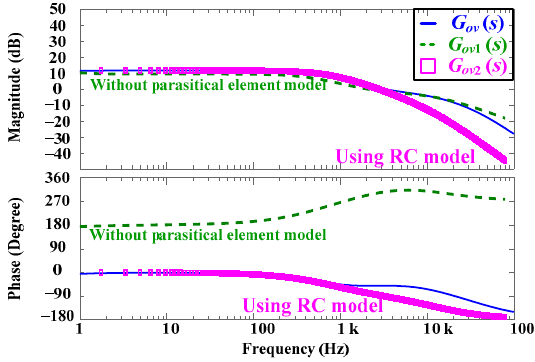
Figure 10. Frequency response simulation using different battery models.